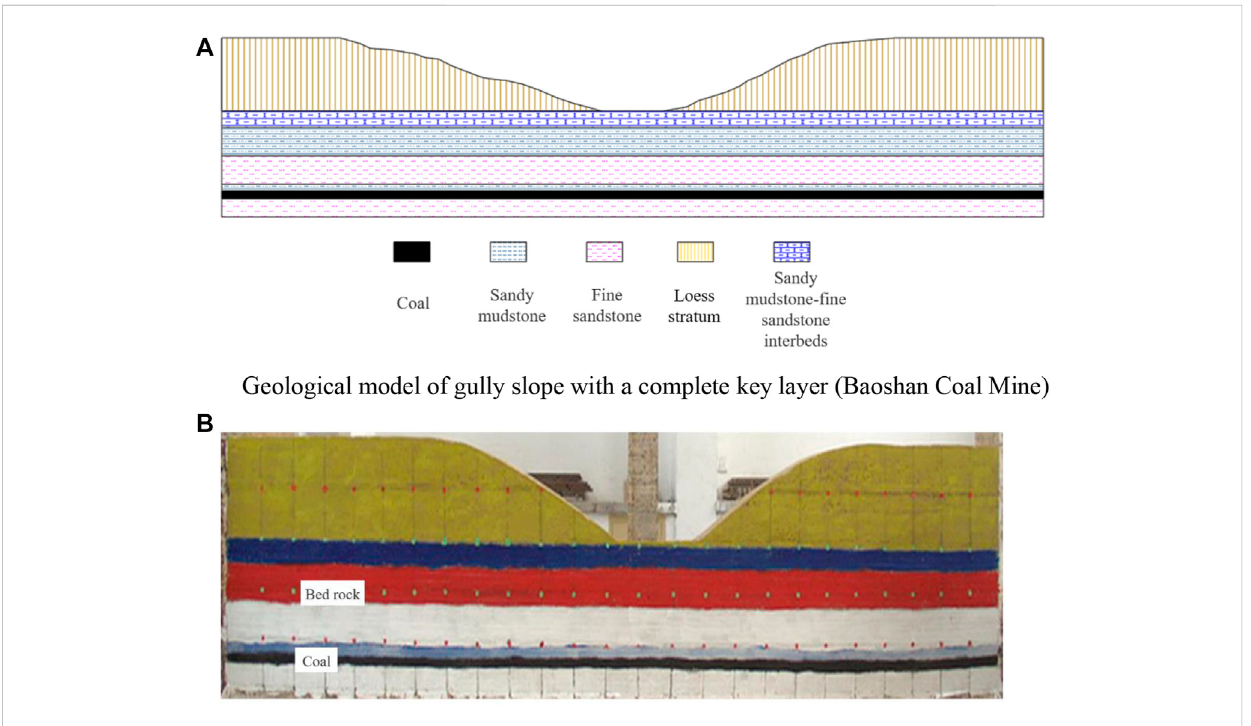
FIGURE 4 Similarphysicalexperiment ofgully slope withan incompletekeylayer. (A) Geological modelofgully slope with acompletekeylayer (BaoshanCoal